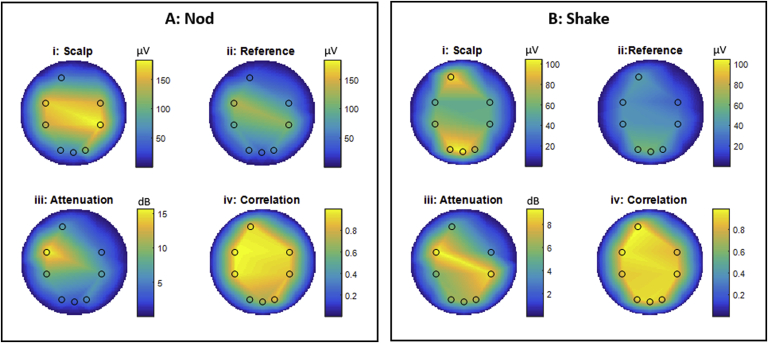
Flat-maps showing the results from EEG experiments on gel phantoms onto which the RLAS cap had been placed. The values shown are calculated as an average across all three recordings acquired from two separate sessions. Box A shows the results for a nod motion, where box B displays the results from a shake motion. i and ii show the RMS values of the EEG data for the channels connected directly to the phantom (scalp) and the isolated reference layer, respectively. iii show the attenuation of the scalp artefacts produced by directly subtracting the reference layer recording and iv show the correlation coefficients between timecourses used to generate i and ii. Note the difference in colour-bar scales for head nod and shake movements.